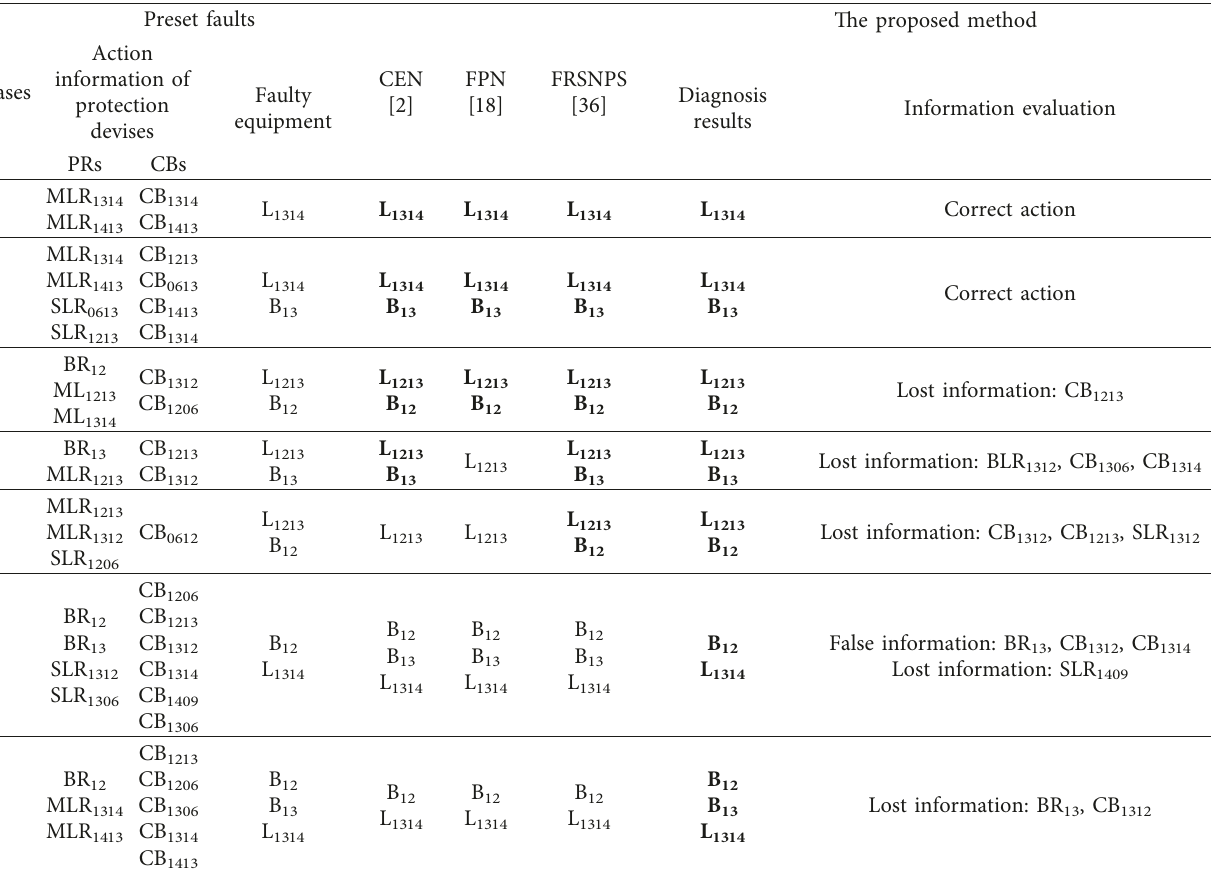
Table 1: Comparisons of diagnosis results between the proposed method and three typical fault diagnosis methods for the 14-bus system.